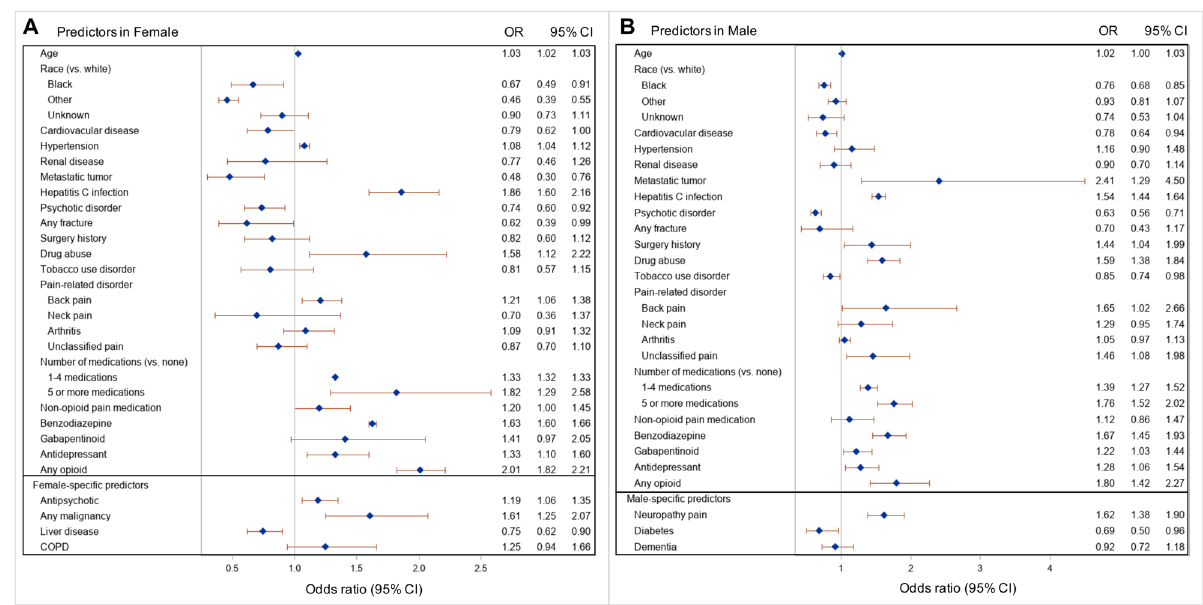
Figure 2. Forest plot presenting the predictors (reduced model) of chronic opioid therapy initiation in female ( A ) and male ( B ) Medicaid beneficiaries with patients with HIV. Note Generalized estimating equation multivariable logistic regressions, accounting for clustering at the state level, were used and the reduced model was selected by backward